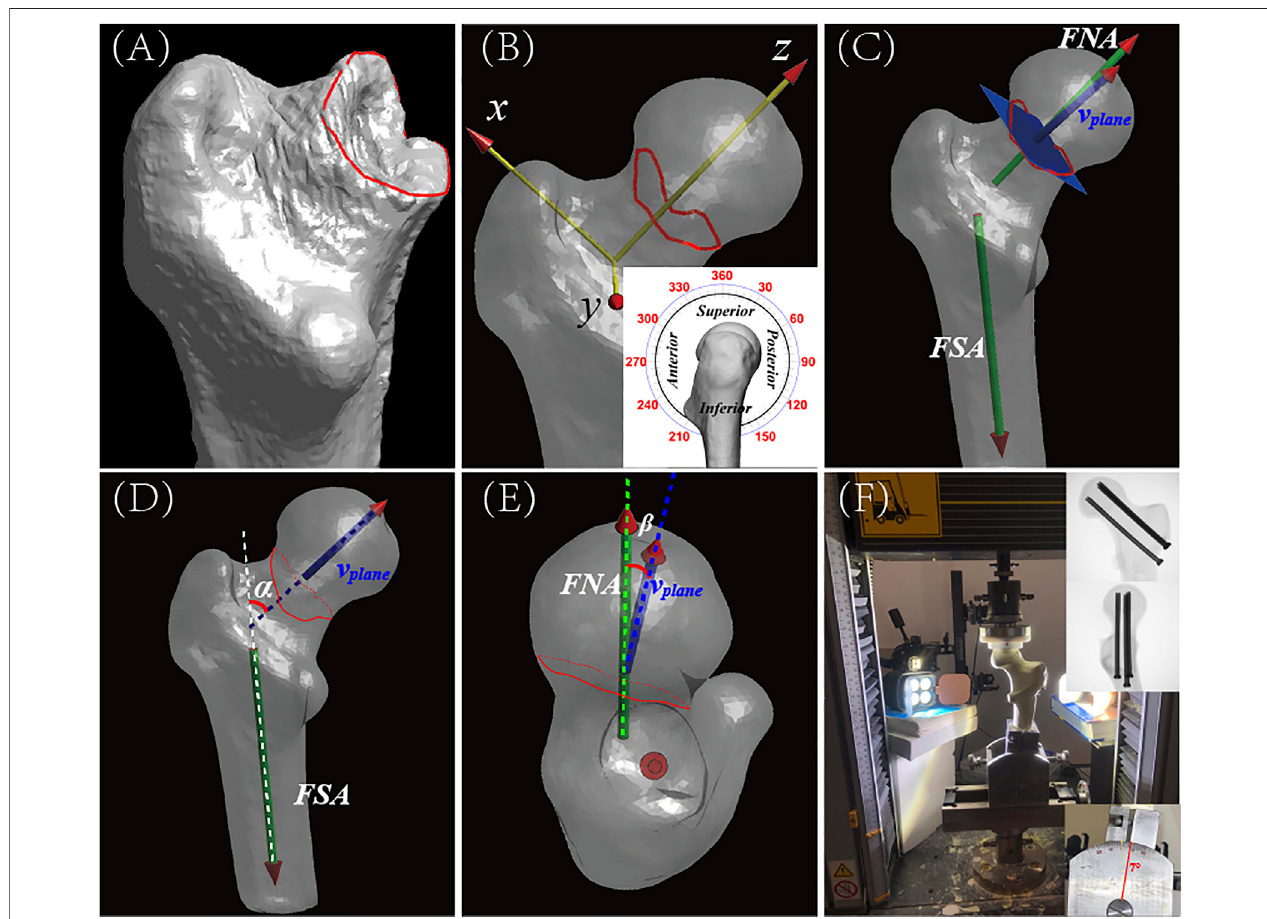
FIGURE 2 | The measurement of Fracture inclination in multiple planes from CT images, and the setup for the biomechanical validation study. (A) Anteroposterior (AP)viewofreconstructeddistalfragmentofproximalfemurandneckshowingpositionofFNF.Thefractureline(red)wasmanuallytracedalongthecorticaledgesofthe distal fragment in 3-Matics ® software. Proximal fragment is hidden in this image. For orientation purposes, lesser trochanter occupies the lower foreground. (B) Local coordinate axes (X, Y, Z) overlaid on complete 3-D reconstruction. Local coordinate axes (X, Y, Z) overlaid on complete 3-D reconstruction. Fracture line was dividedintoequalsectionsordegreesusingtheclassicalclock-facesystem(inset,lateralview).Fororientation,0 ° /360 ° (i.e.,12o ’ clock)pointstowardthesuperiorpartof the femoral head and 180 ° (i.e., 6 o ’ clock) points toward its inferior part. The clock-face system was then digitally transposed onto the custom proximal femoral coordinate system. (C) AP view of reconstructed proximal femur showing orientation of the fracture plane, which is represented by the blue-colored rectangle. v plane represents the normal vector of the fracture plane. FSA, femoral shaft axis; FNA, femoral neck axis. (D) AP view of the reconstructed proximal femur showing how proposed classi fi cation parameters were determined. α (red) is de fi ned as the angle between v plane (blue, projected on vertical plane) and the FSA (white dotted line). (E) Axial view of the reconstructed femur showing femoral head and determination of proposed classi fi cation parameters. β is de fi ned as the angle between v plane (blue, projected on coronal plane) and the FNA (green dotted line). β is a measure of the axial obliquity of a fracture. (F) Photograph of the biomechanical test setup showing a simulated FNF in a Synbone ® . In the biomechanical test, a simulated fracture was made in a Synbone ® , the fracture was fi xed with standard cannulated orthopaedic screws,andthefemoralshaftwas fi xedintheInstrontestinginstrumentatashaftadductionangleof7 ° (lowerinsetphotograph).Interfragmentarymotion(IFM)wasthen recorded using a VIC-3D 9 system (Correlated Solutions, Inc.). As progressively greater downward force was applied to the fi xed Synbone ® , high-speed digital images were acquired of the Synbone ® and stored for later analysis. The digital images were imported into MATLAB software, and IFM was calculated for each of the seven groups of simulated FNFs. Top inset shows postoperative radiograph of fi xation screws in Synbone ® .